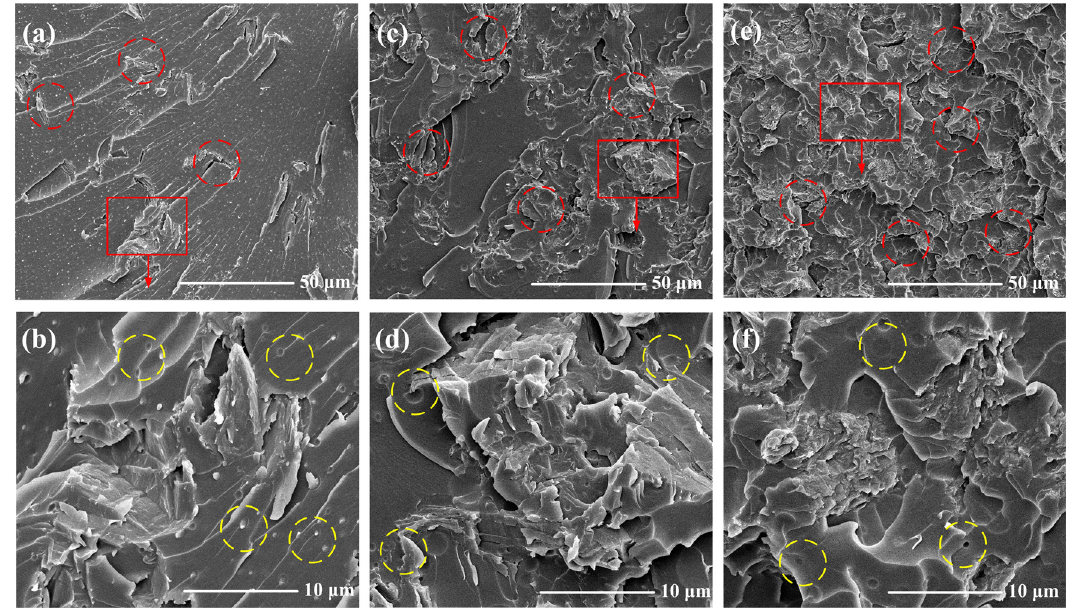
Figure 3: SEM micrographs of the GO/PVB/EP coating specimens. ( a ) and ( b ) 0.38 wt% of GO content; ( c ) and ( d ) 0.635 wt% of GO content; ( e ) and ( f ) 0.89 wt% of GO